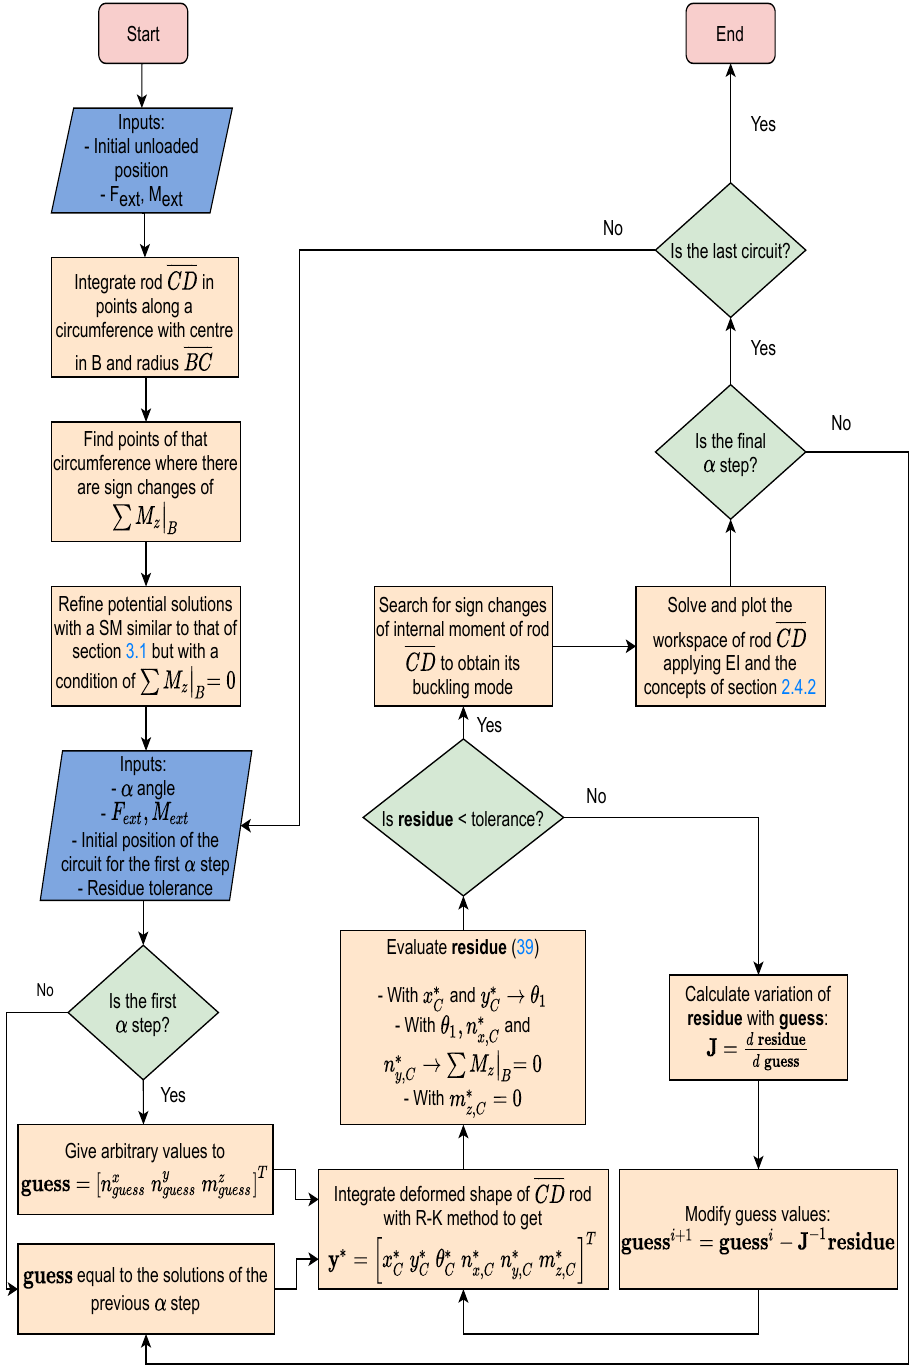
Figure 23. Flowchart of the entire